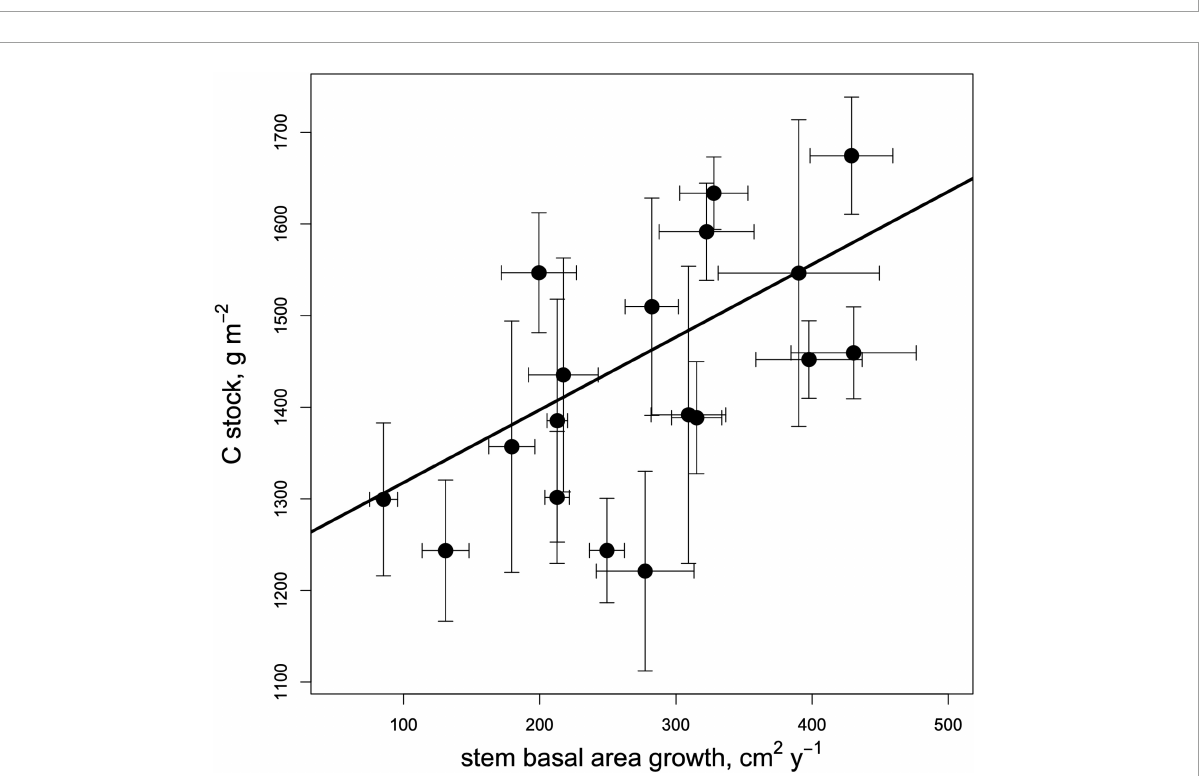
FIGURE3 Relationship between species-mean soil C stocks (to 5 cm depth) and productivity (annual stem basal area increase) across the 19 trees species in the biodiversity ecosystem function experiment with trees (IDENT) Montreal common garden. Error bars (x and y) represent ± 1 SE ( N = 4 plots per